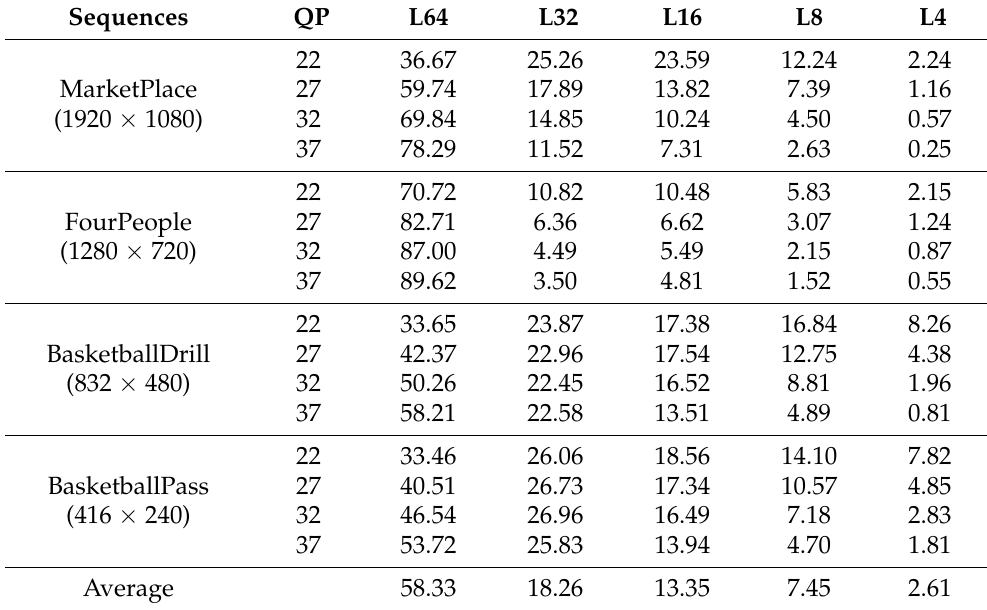
Table 2. Optimal CU size distribution under different QPs (unit: